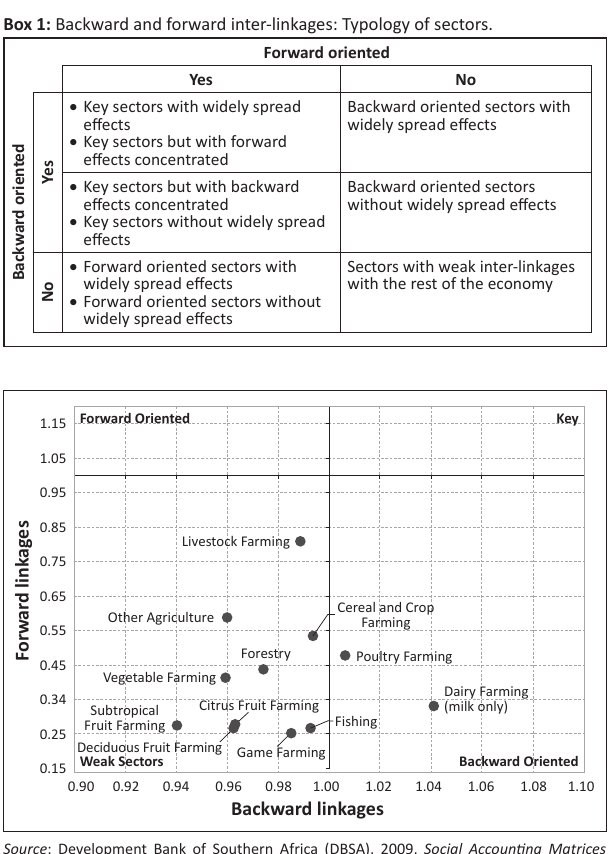
FIGURE 1: Backward and forward linkages of the primary sectors. FIGURE 2: Production